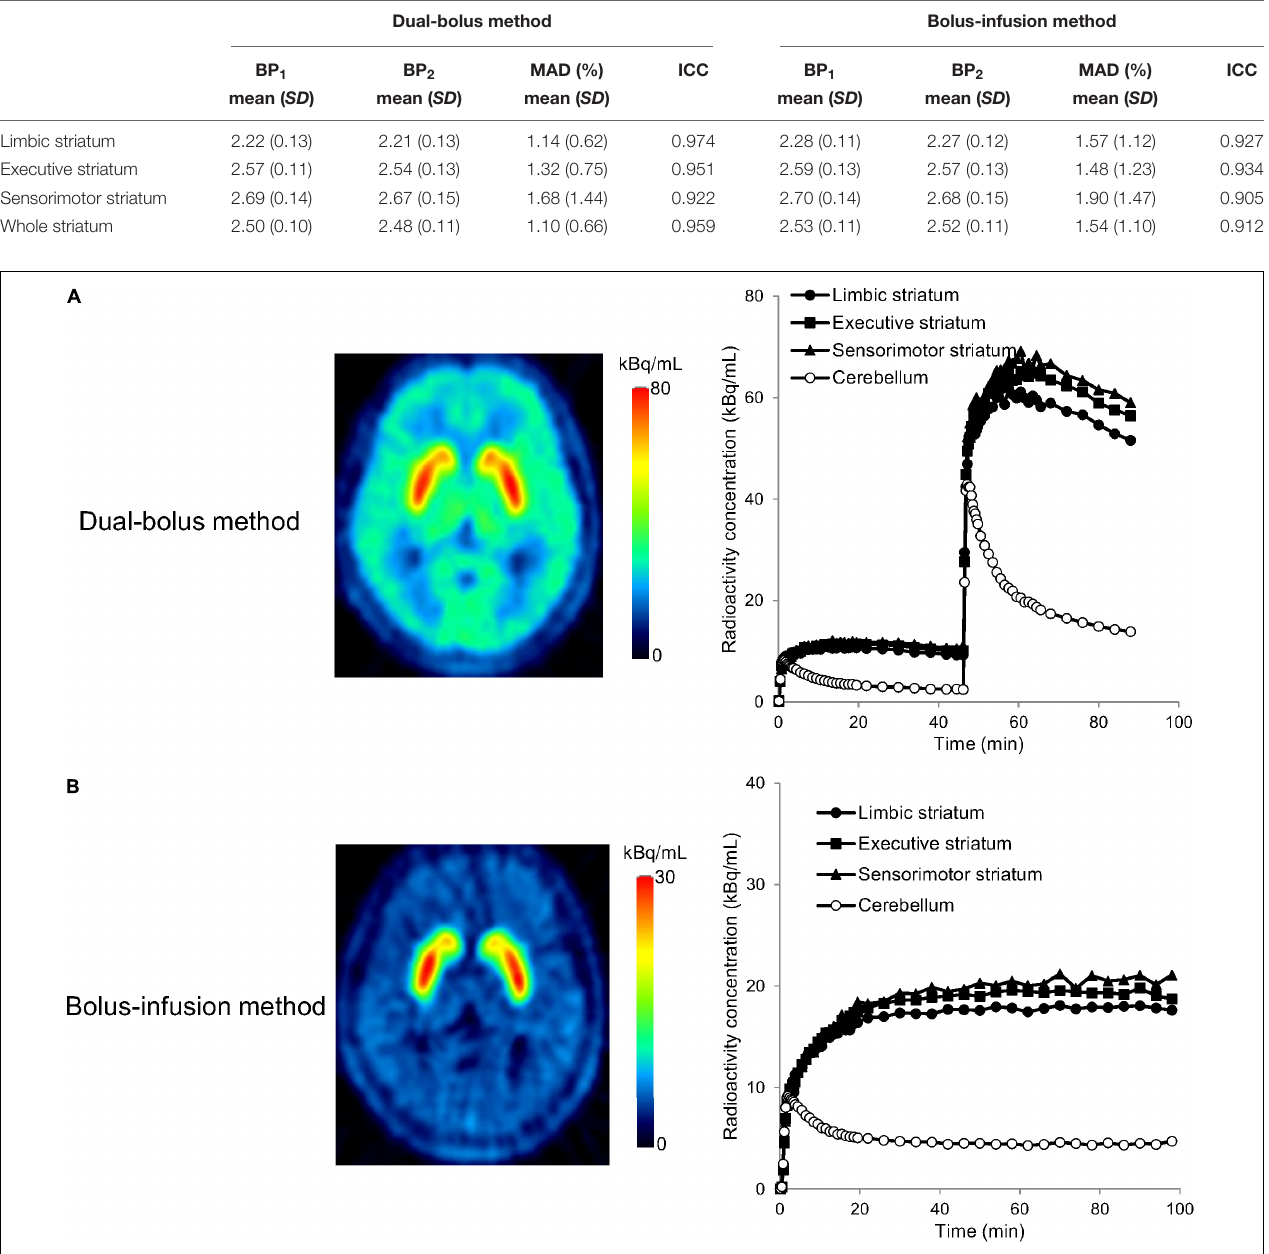
FIGURE 4 | Positron emission tomography (PET) images and time-activity curves of the limbic striatum, executive striatum, sensorimotor striatum, and cerebellum for the dual-bolus method (A) and bolus-infusion method (B) in [ 11 C]raclopride-PET studies with cognitive tasks. PET images show the averaged radioactivity concentration for the second section after the stimulation (45–89 min for the dual-bolus method, 60–100 min for the bolus-infusion method). Time-activity curves were decay corrected to the time of the scan